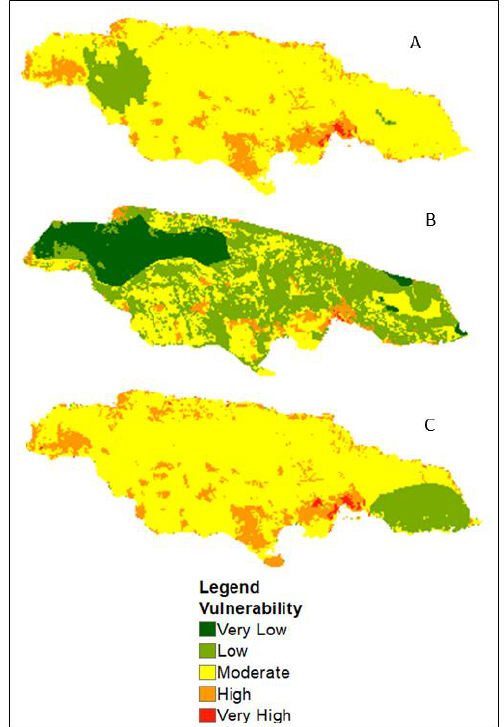
Figure 3. Dengue vulnerability with ( A ) WorldClim dataset, ( B ) CHIRPS rainfall and LST, and ( C ) climate change projection for 2030 for the month of May.